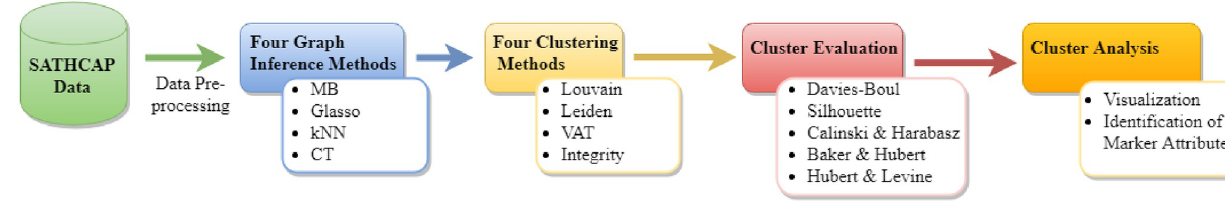
Fig 1. Overall workflow for inferring SATHCAP